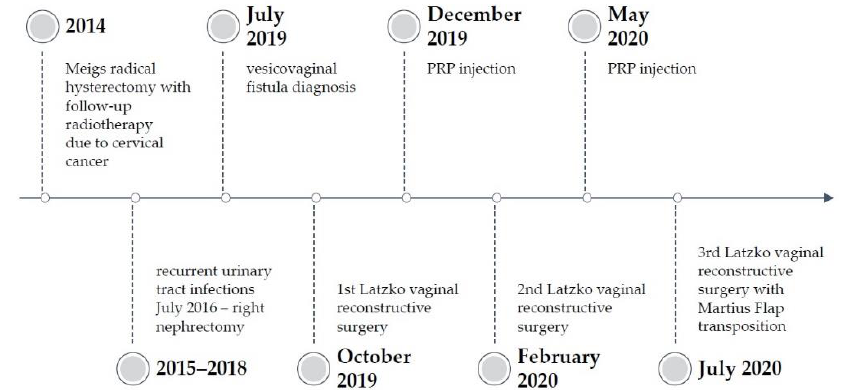
Figure 2. Timeline of the procedures.